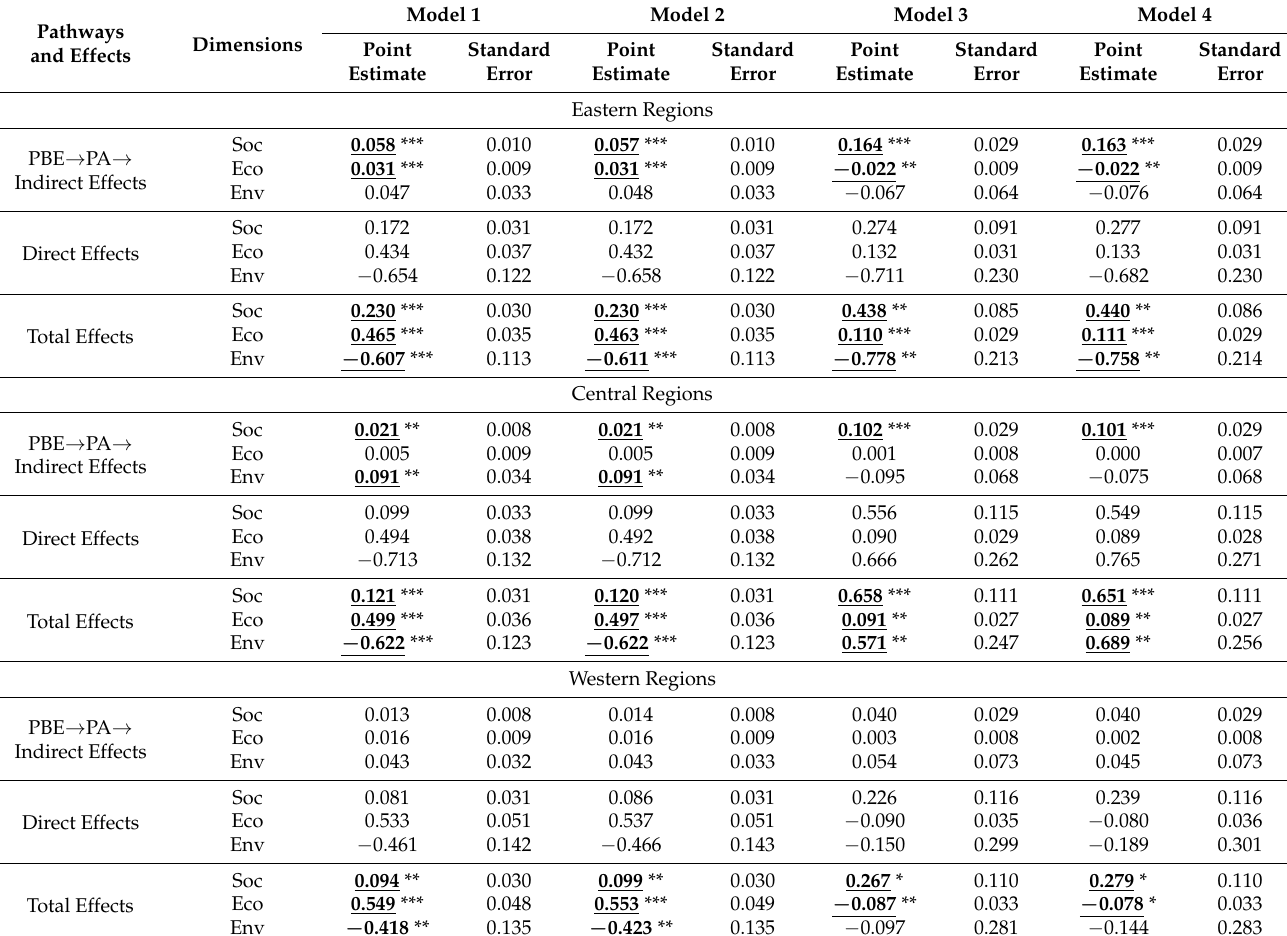
Table 5. Total, direct and indirect effects of PBE on P-RCR in terms of Soc, Eco and